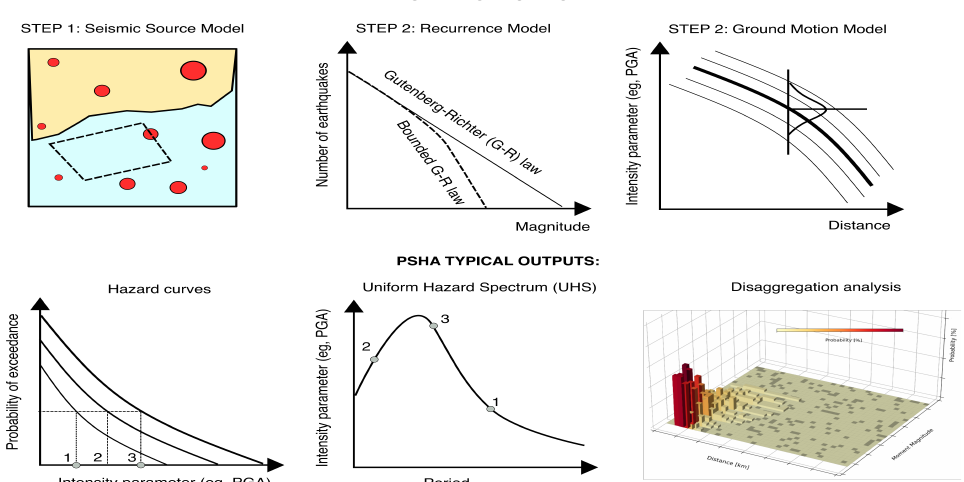
Figure 9. An overview of the steps involved in a typical probabilistic seismic hazard assessment (PSHA) [20,21] and corresponding